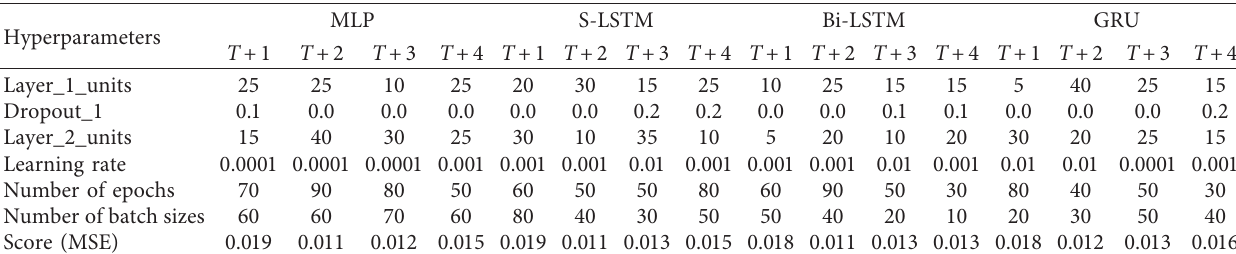
Table 3: Keras tuner optimized hyperparameter values for Gummera station with its MSE score. Hyperparameters